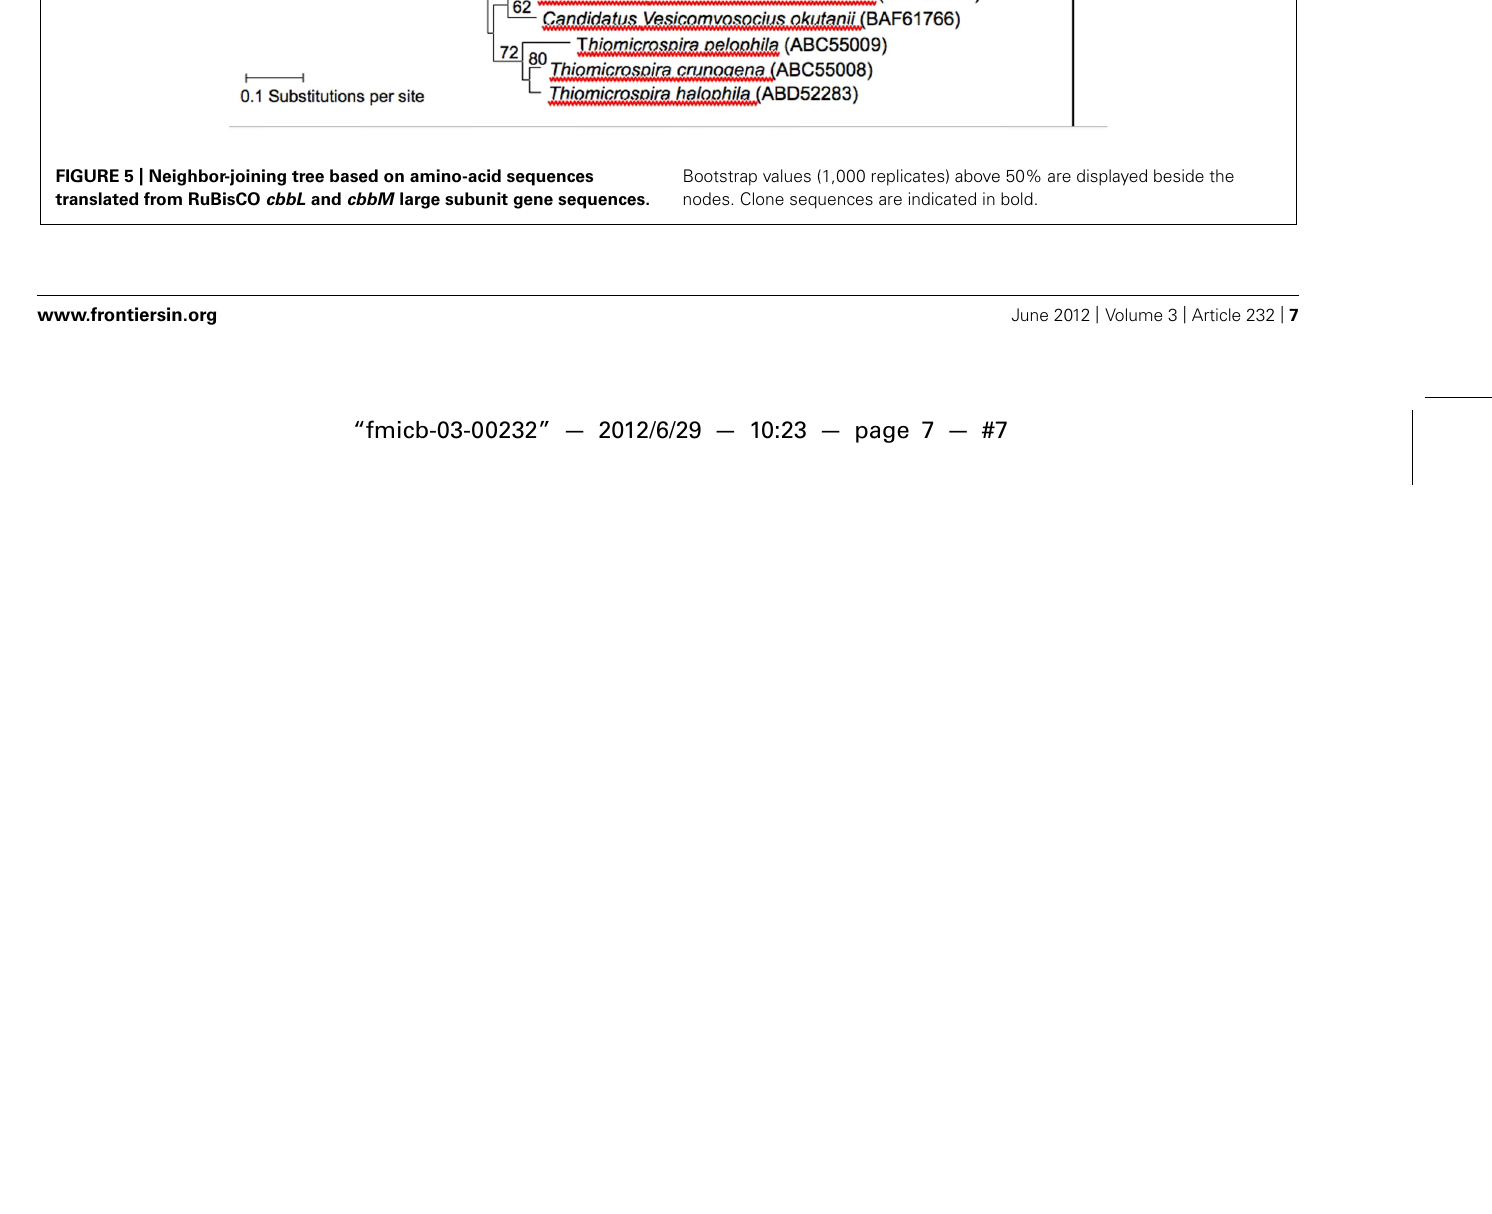
FIGURE 5 | Neighbor-joining tree based on amino-acid sequences translated from RuBisCO cbbL and cbbM large subunit gene sequences.